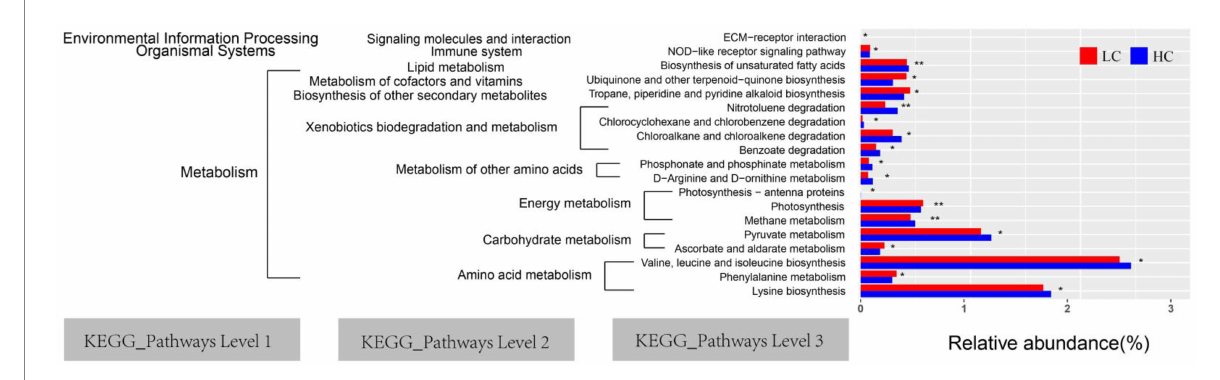
FIGURE 7 Yaks, which were fed low concentrate (LC) and high concentrate diets (HC), had significantly different functional predictions of the rumen microbiota of the KEGG pathway ( p < 0.05). The graph shows the KEGG pathways for levels 1, 2, and 3. “*” and “**” indicate significance levels of 0.05 and 0.01,